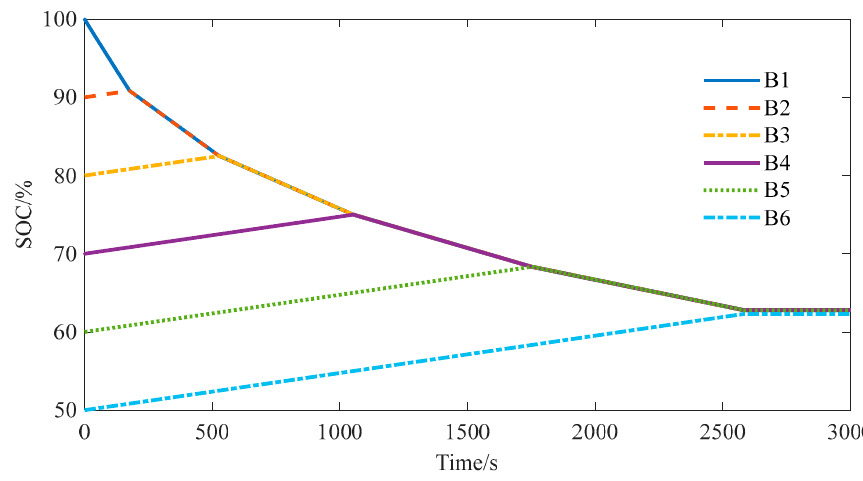
Figure 19. Equilibrium results of peak clipping scheme under Standing condition.